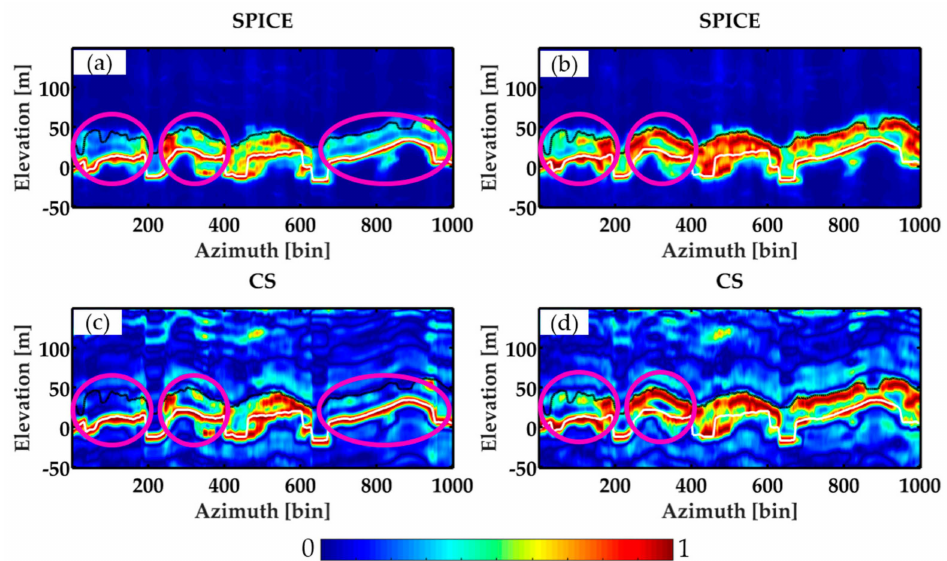
Figure 10. Tomograms estimated by the two tomographic algorithms in two polarimetric channels: ( a ) W&O-SPICE in the HH polarization; ( b ) W&O-SPICE in the HV polarization; ( c ) W&O-CS in the HH polarization; ( d ) W&O-CS in the HV polarization. The solid black line represents the LiDAR CHM, and the solid white line represents the LiDAR